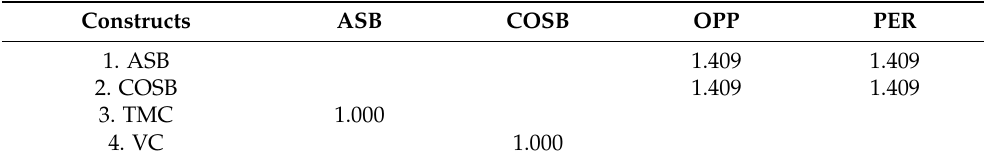
Table 2. Inner VIF